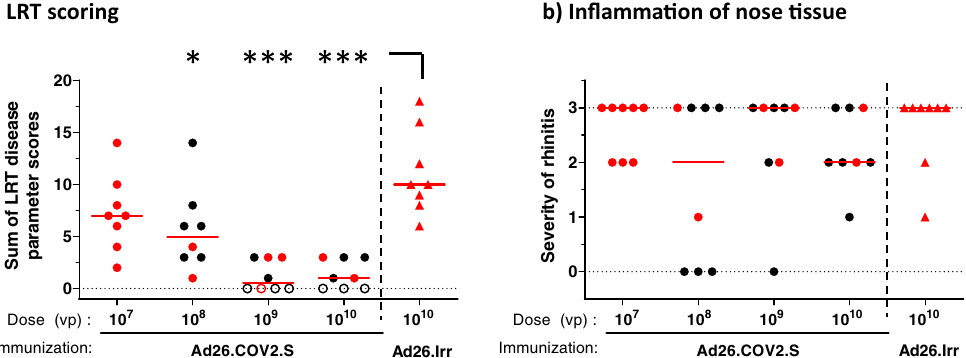
Fig. 5 No signs of VAERD in Ad26 immunized Syrian hamsters inoculated with SARS-CoV-2. Four days after IN inoculation with 10 2 TCID 50 SARS-CoV-2 ( N = 8 per group), a lung tissue was isolated and scored for presence and severity of alveolitis, alveolar damage, alveolar edema, alveolar hemorrhage, type II pneumocyte hyperplasia, bronchitis, bronchiolitis, peribronchial and perivascular cuf fi ng. Sum of scores are presented as the sum of LRT disease parameters. b Four days after inoculation, nose tissue was isolated and scored for severity of in fl ammation (rhinitis). Horizontal lines denote a pathology score of 0, indicating no histopathology. Symbols in red denote samples from hamsters with breakthrough lung viral load (>10 2 TCID 50 /g). Comparisons were performed between the Ad26.COV2.S dose level groups, with the Ad26.Irr group by Mann – Whitney U test. Statistical differences indicated by asterisks: * p < 0.05; ** p < 0.01; *** p < 0.001. Ad26.Irr Ad26 vector not encoding any SARS-CoV-2 antigens, LRT lower respiratory tract, N number of animals, VP virus